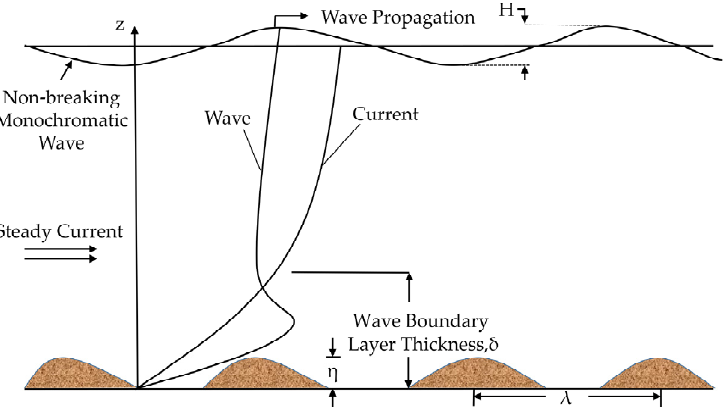
Figure 1. Physical conceptual diagram of flow in combined wave-current motion over ripples (after [39]) .